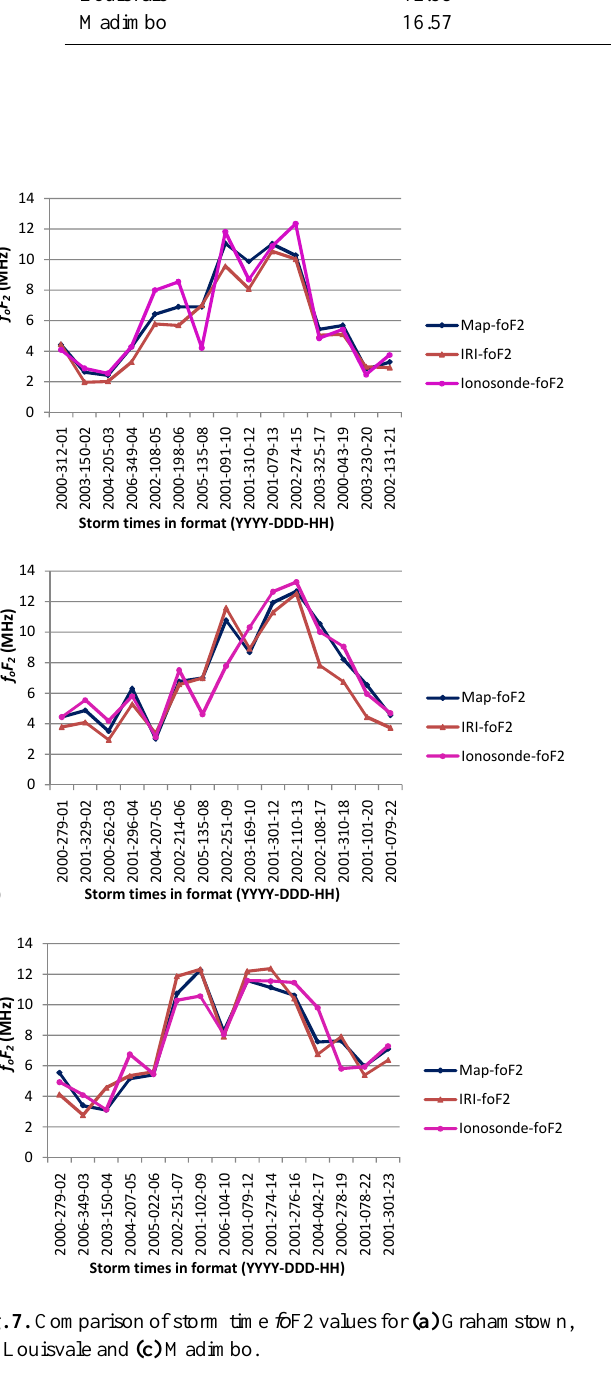
Table 2. Deviation of the MAP- fo F2 values and the IRI- fo F2 values from ionosonde- fo F2 values, as calculated from Eq. (3). Average of the absolute percentage Average of the absolute percentage Station deviations of the MAP- fo F2 deviations of the IRI- fo F2 values values from the ionosonde fo F2 values (%) from the ionosonde fo F2 values (%) Grahamstown 18.14 Louisvale Madimbo